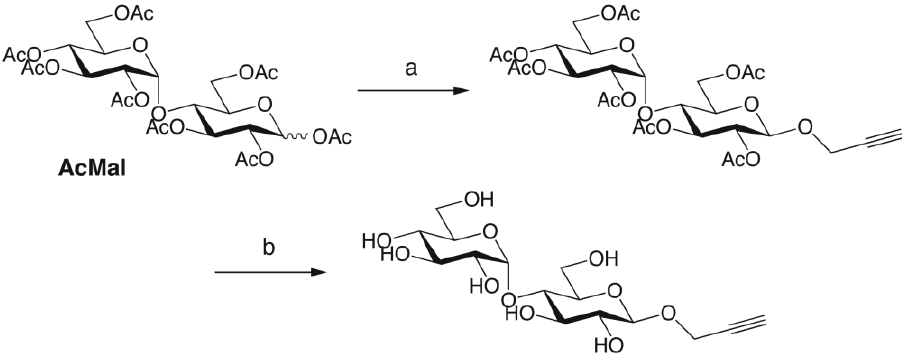
Scheme 2. Synthesis of the N -linked  -maltoside having terminal alkyne ( N